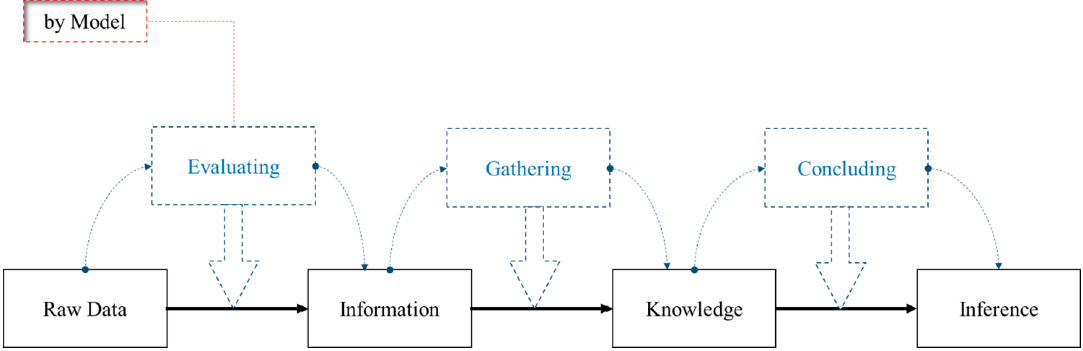
Figure 1. An overview of the inference process and its key elements [38].